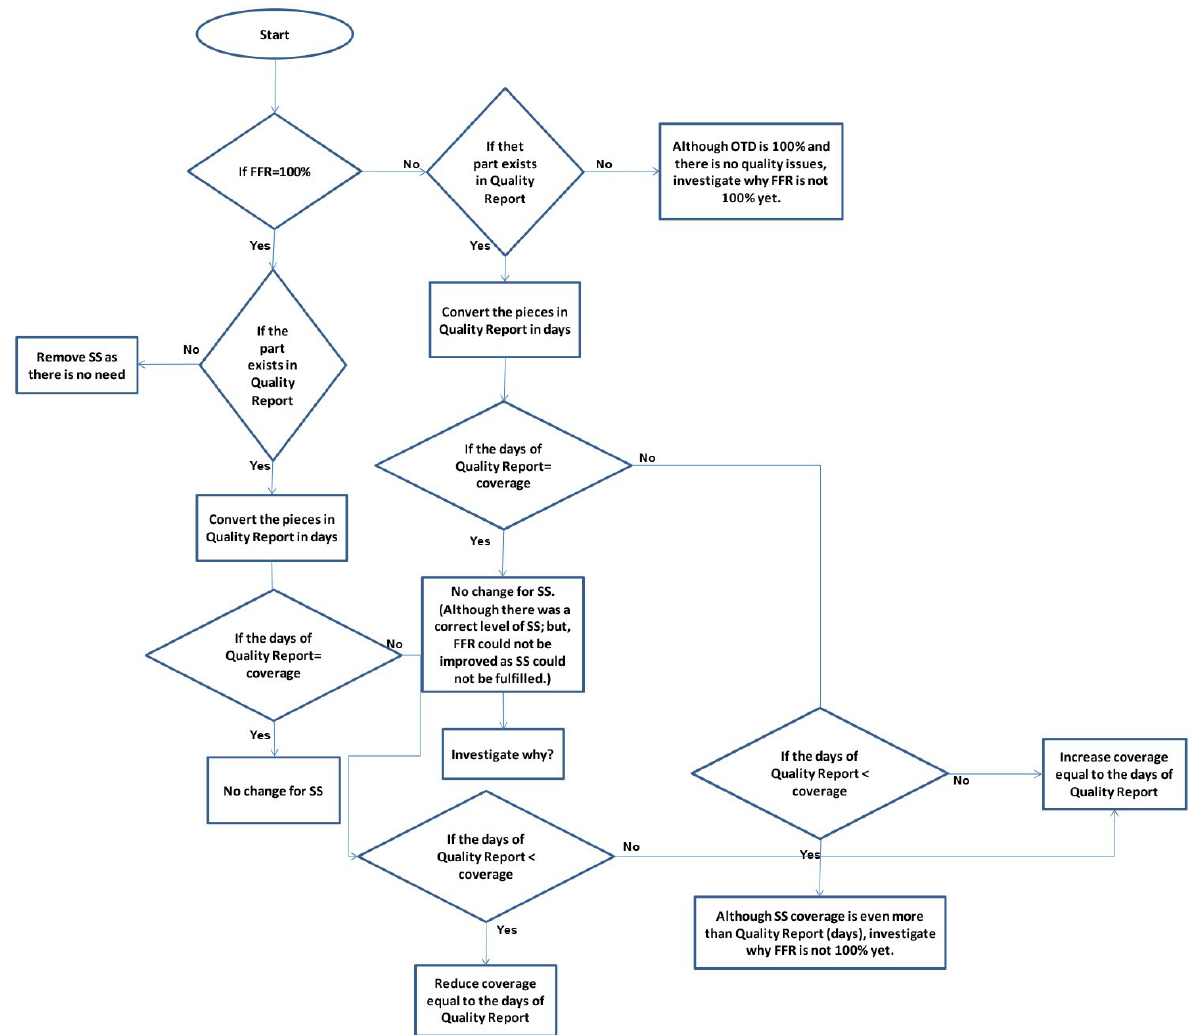
Figure 10. Green area